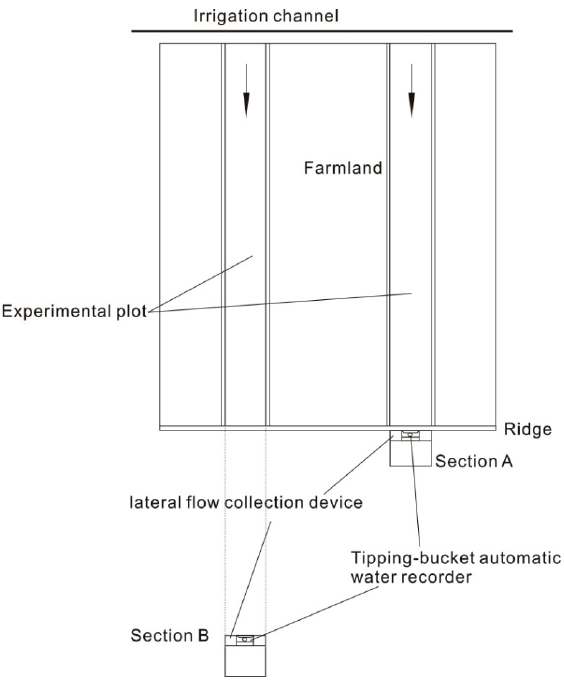
Figure 2. Schematic diagram of the system for monitoring subsurface lateral flow and nitrogen transport processes in the rock.